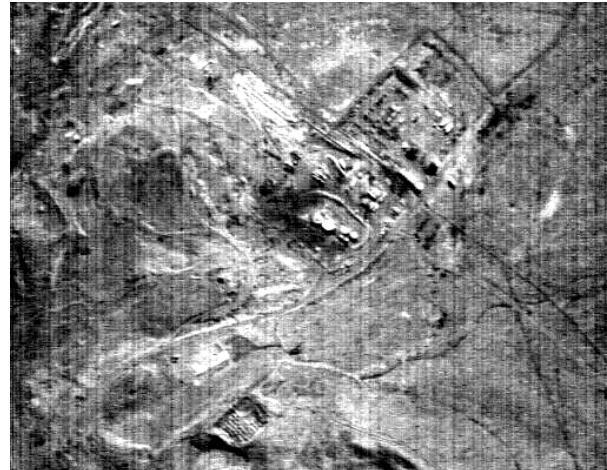
Figure 1. A 7.68µm HyTES band image recorded on 5 Febru- ary 2015 with a ground sample distance of 2m This image was used to validate our model method in MODTRAN 6.